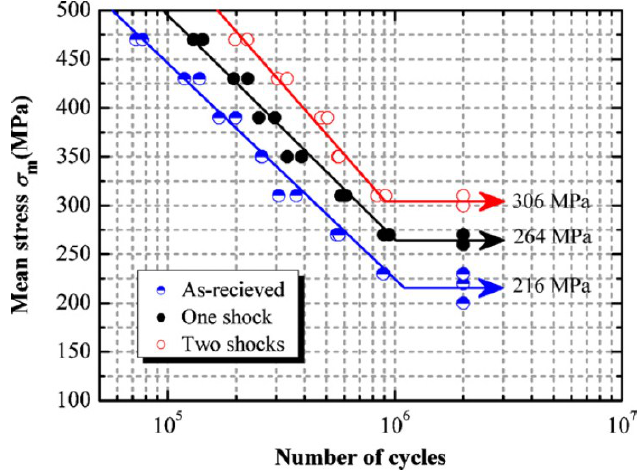
Figure 18. Fatigue lives of laser-peened and as-received Ti-6Al-4V at different applied stress levels